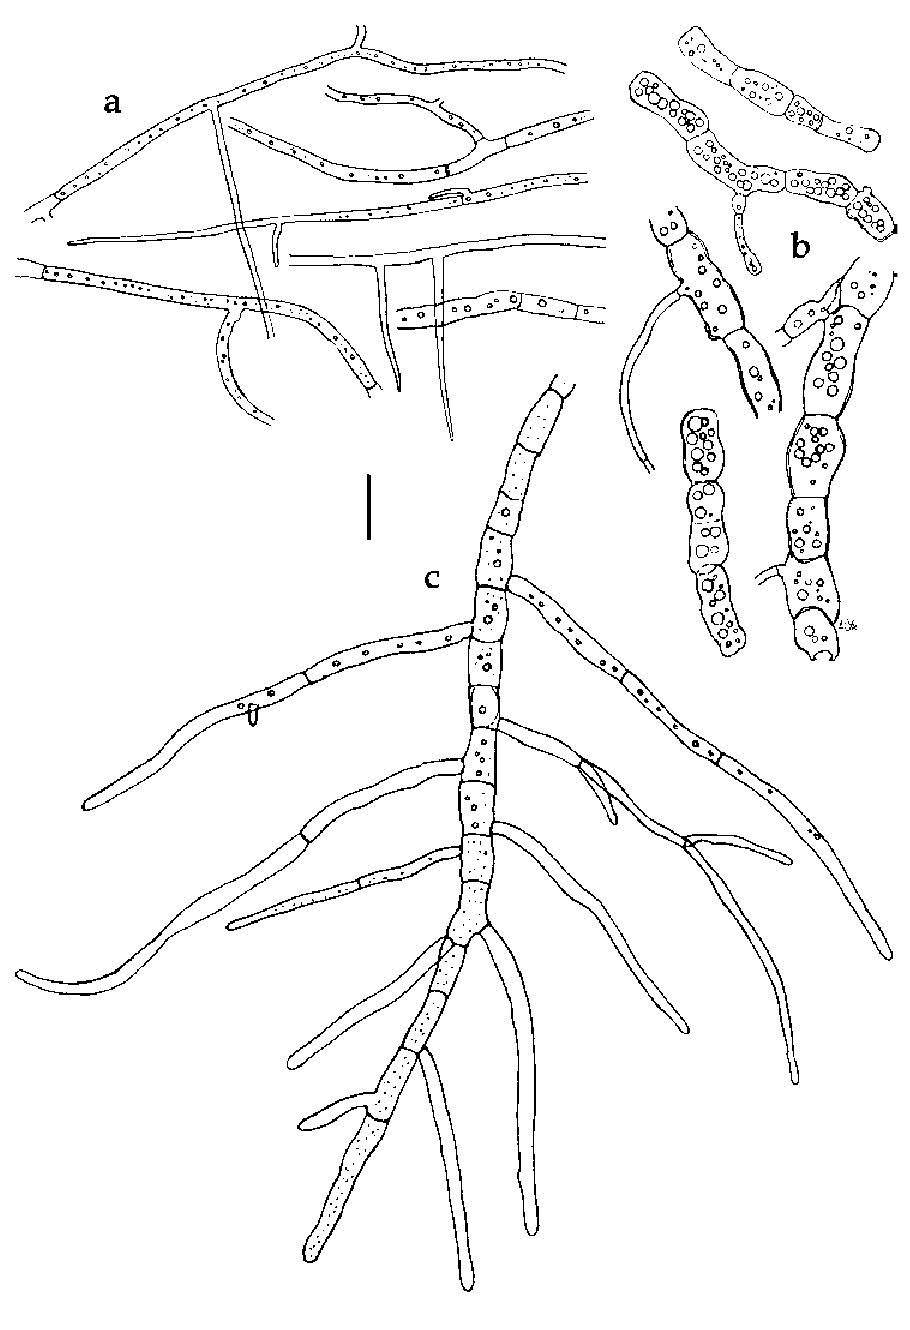
Fig. 2. Robillarda sessilis hyphae in culture: a – aerial, b – repent and immersed, c – marginal. Scale bar = 10